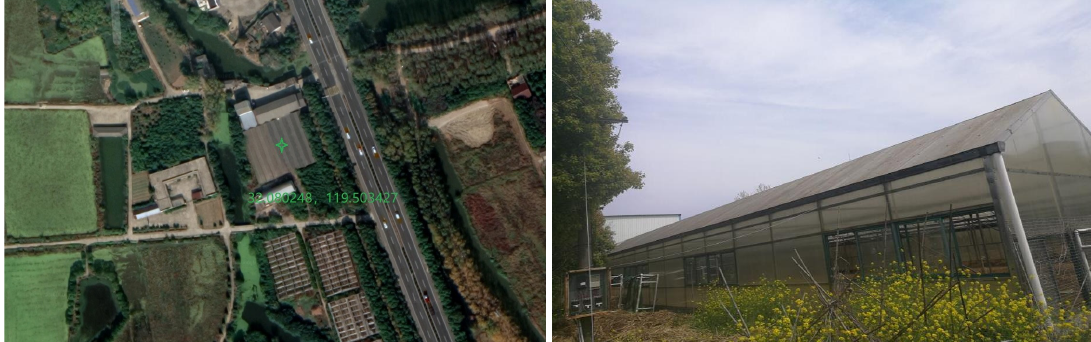
Figure 3. The location and structure of the target